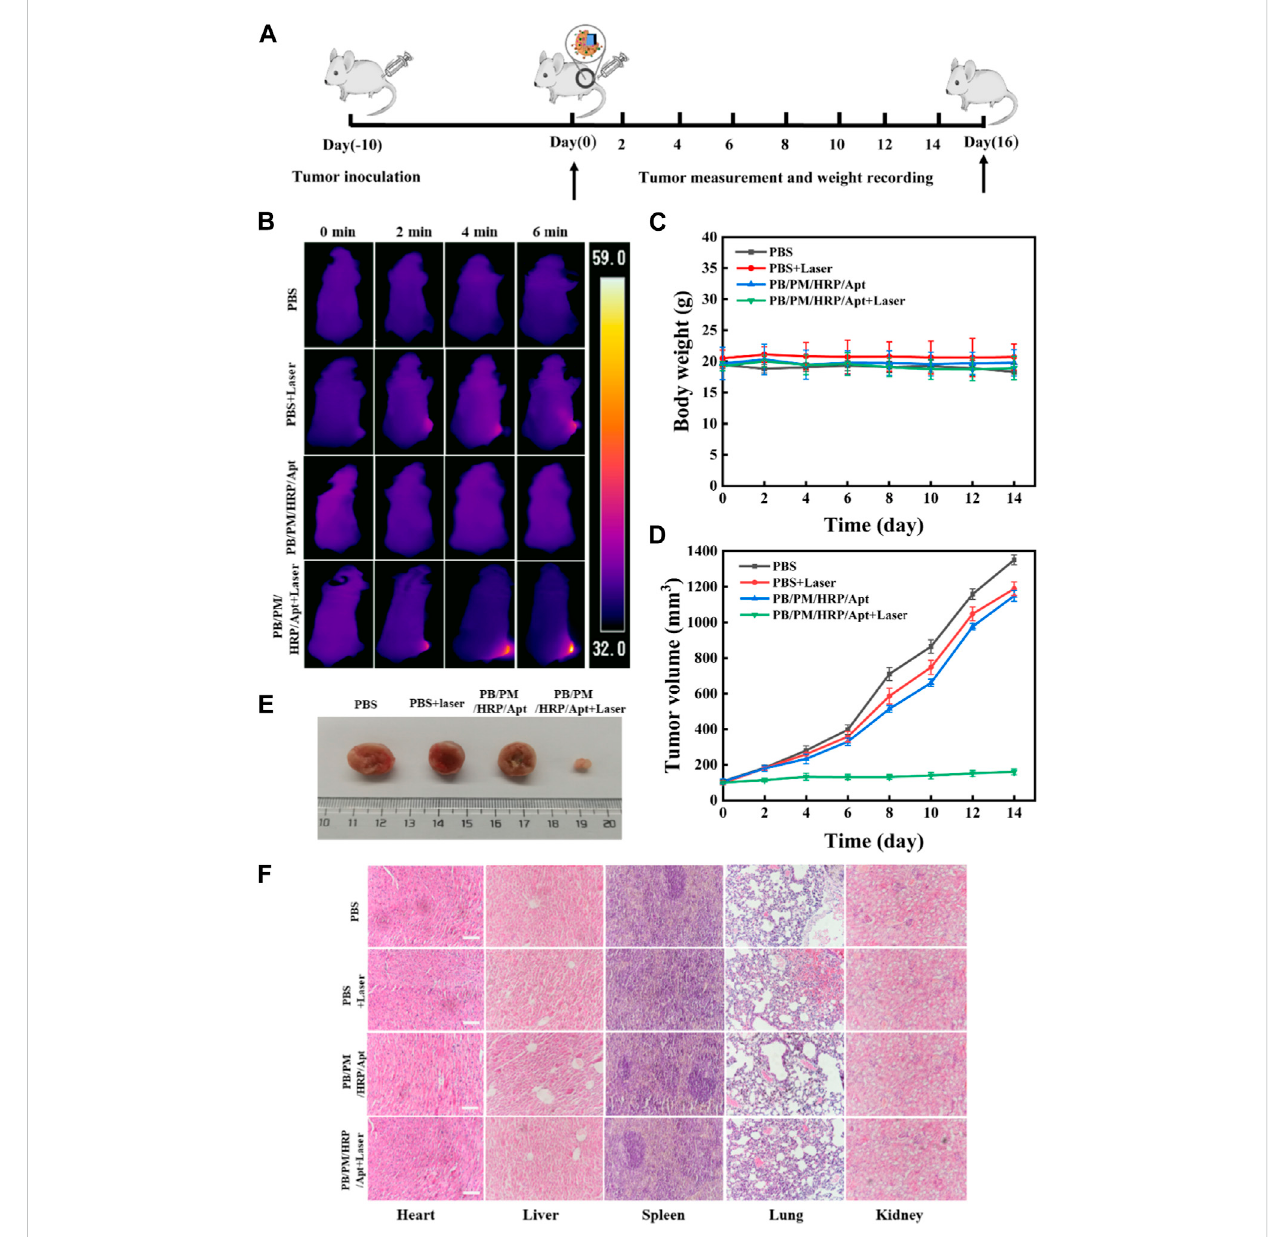
FIGURE 6 Anticancer effect of PB/PM/HRP/Apt in vivo . (A) Schematic representation of tumor formation and treatment outcome in 4T1 tumor-bearing mice. (B) Temperature changes of tumor-bearing mice. (C) Curve of weight change. (D) The corresponding tumor growth curves of 4T1 solid tumor-bearing mice monitored every 2 days after different treatments, and the data are expressed as mean values (n = 5). (E) Representative digital photographs of dissected tumors in each group after treatment. (F) Histological analysis of major organs was performed by H&E staining. Scale bar: 100 μ